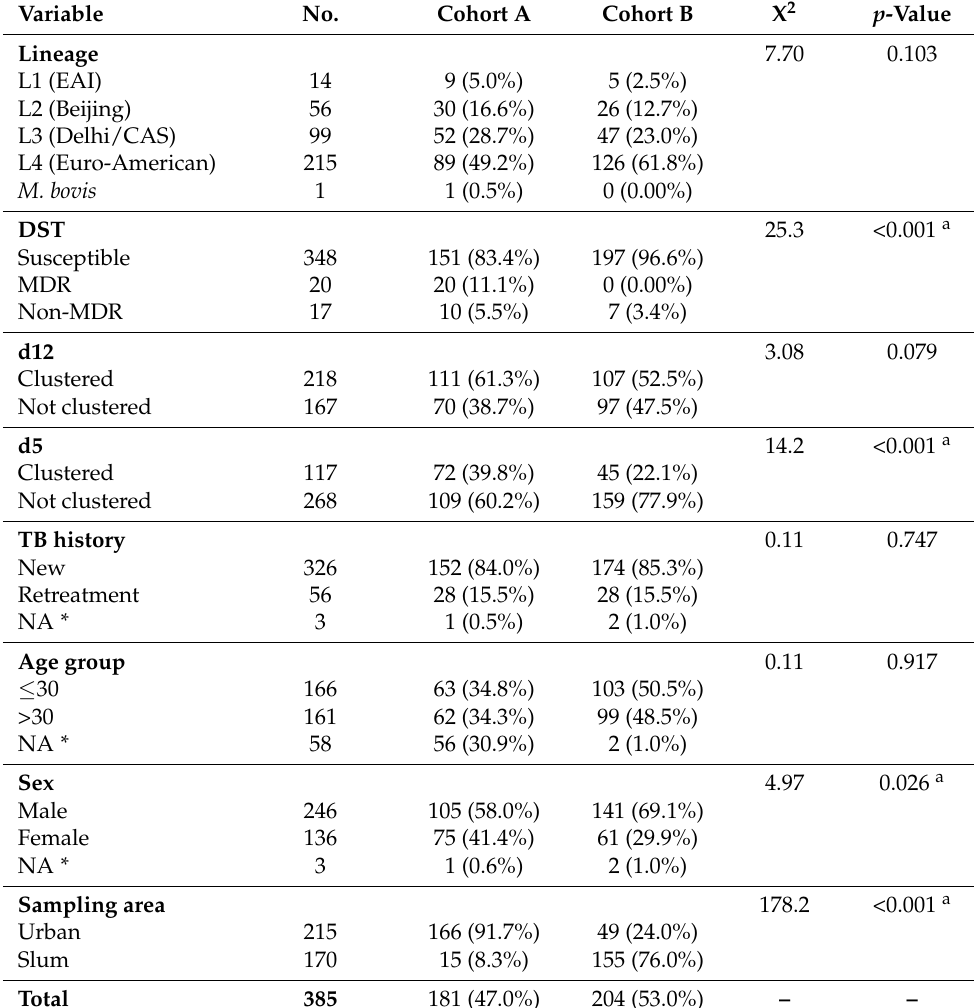
Table 1. Comparison of the two patient cohorts investigated by using chi-square test in Nairobi, Kenya (2010–2015). Variable No. Cohort A Cohort B X 2 Lineage